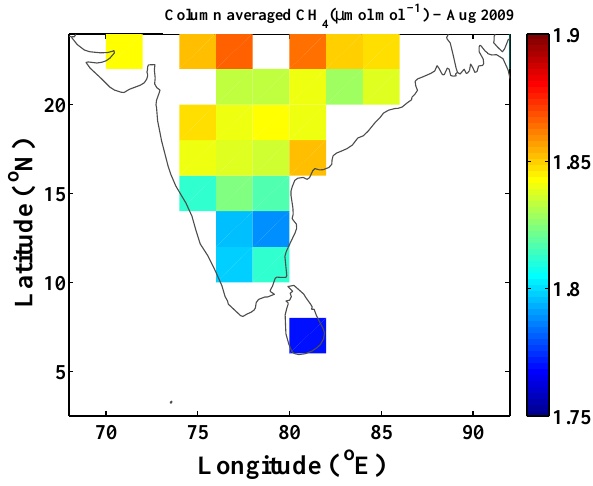
Figure 5. Backward air mass trajectories (black curves) 500m above the location of higher CO observations as marked by red arrows in Fig. 4b during 7 and 11 August 2009. The background colour map shows the spatial distribution of anthropogenic CO emissions over the Indian region for the year 2006 from INTEX-B inventory. The small circles in magenta represent the points where observations were made, as well as the end point of trajectories. The white circle over the hotspot region denotes an observational site, Bhubaneswar.